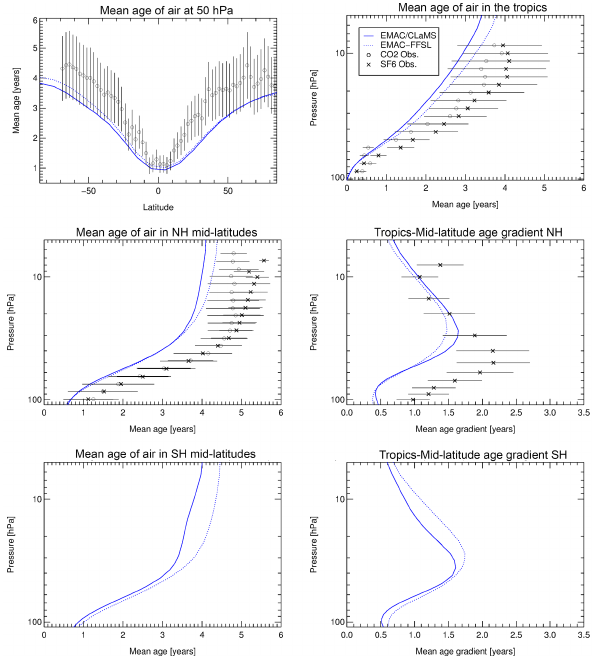
Figure 2. Zonal mean age of air [years]: simulation results of EMAC/CLaMS as solid blue line, EMAC-FFSL as dotted blue line, and mean age from measurements (SF 6 , black crosses; CO 2 , black circles; Andrews et al., 2001; Engel et al., 2009), shown with 1 σ - uncertainties. The top left panel shows zonal mean age of air at 50hPa. The top right panel shows tropical profiles (10 ◦ N–10 ◦ S), the middle left panel NH mid-latitude profiles (35–45 ◦ N) and the bottom left panel SH mid-latitude profiles (35–45 ◦ S). The differ- ence between the mid-latitude and the tropical profiles are presented in the middle right panel for the Northern Hemisphere, and the bot- tom right panel for the Southern